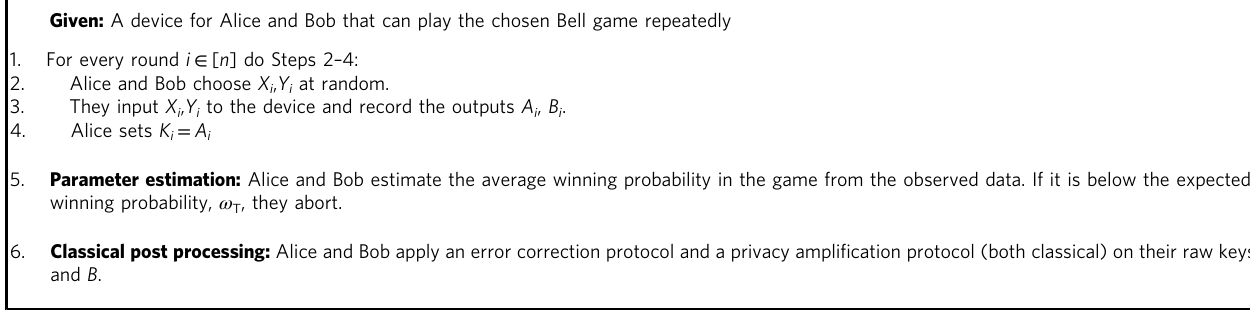
Box 1 | Device-independent quantum key distribution protocol (simpli fi ed example) Given: A device for Alice and Bob that can play the chosen Bell game